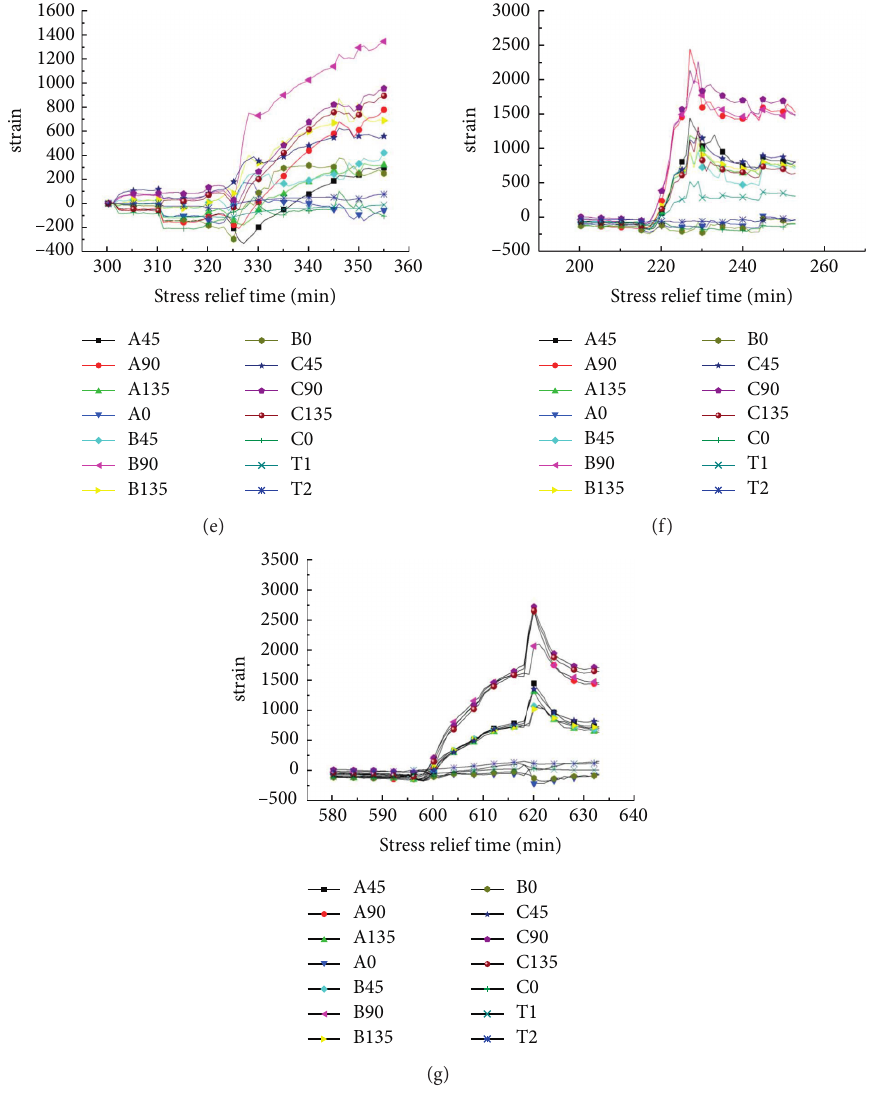
Figure 3: The relief curve of double temperature compensation correction: (a) 350m level 1# measuring point, (b) 350m level 2# measuring point, (c) 300m level 3# measuring point, (d) 300m level 4# measuring point, (e) 250m level 5# measuring point, (f) 100m level 6# measuring point, and (g) 80m level 9# measuring